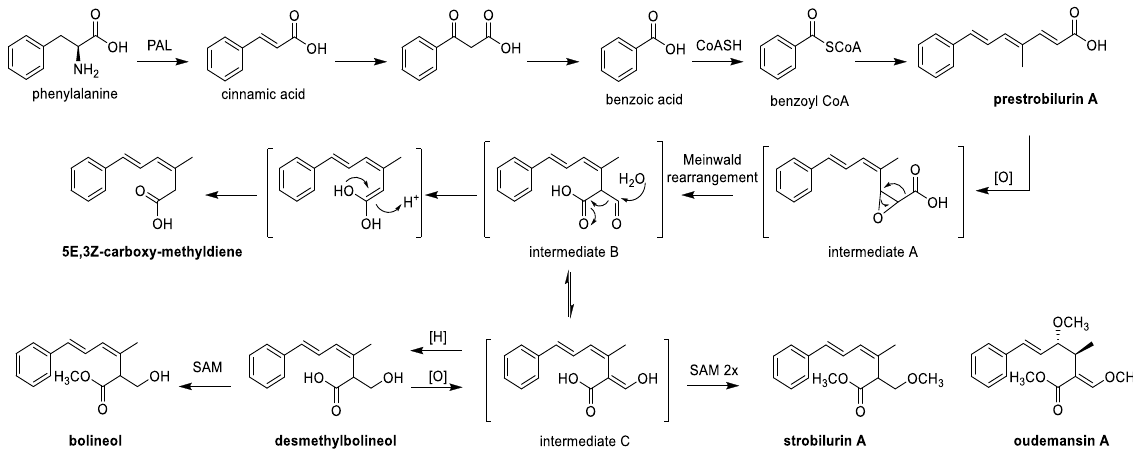
Figure 9. Biosynthesis of strobilurin A [85].